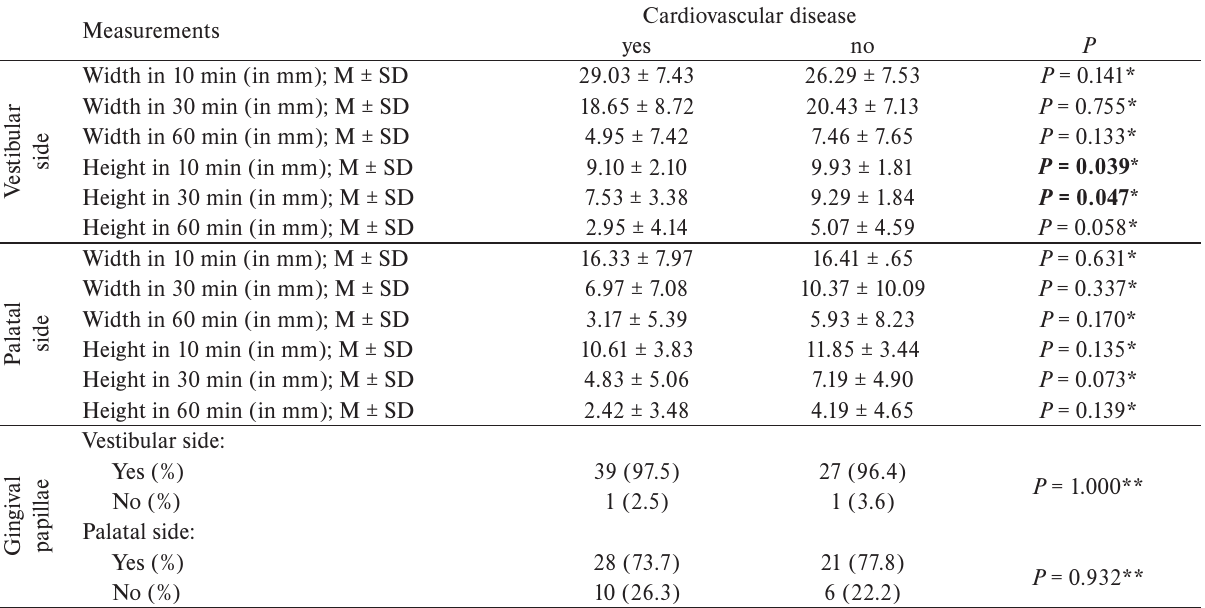
Table 4. Characteristics of the anesthetized area in the study groups.